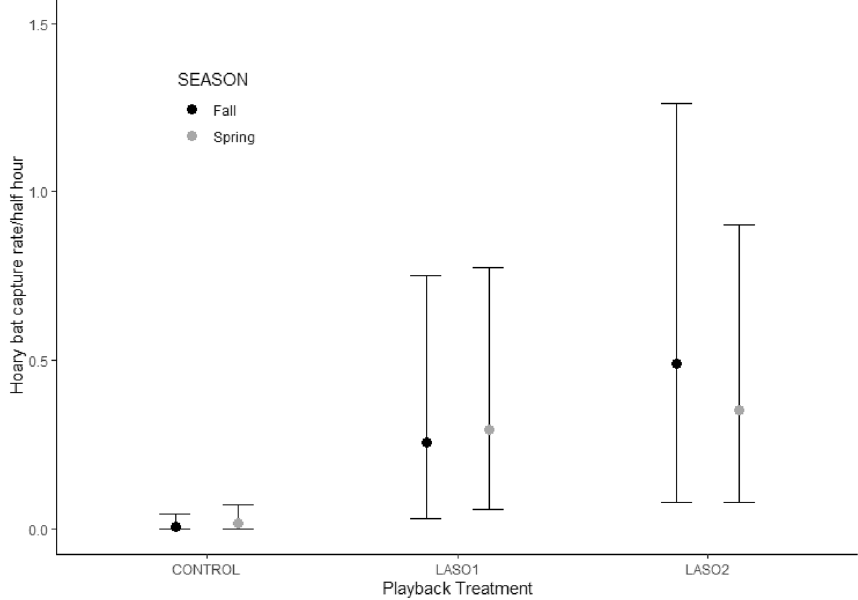
Figure 1. Model result estimates of capture rate of hoary bats ( Lasiurus cinereus ) per half hour during control (n = 52), and social call broadcasting Laso1 (n = 26) and Laso2 (n = 26), with 95% credible intervals, from posterior of Treatment and Season interaction.